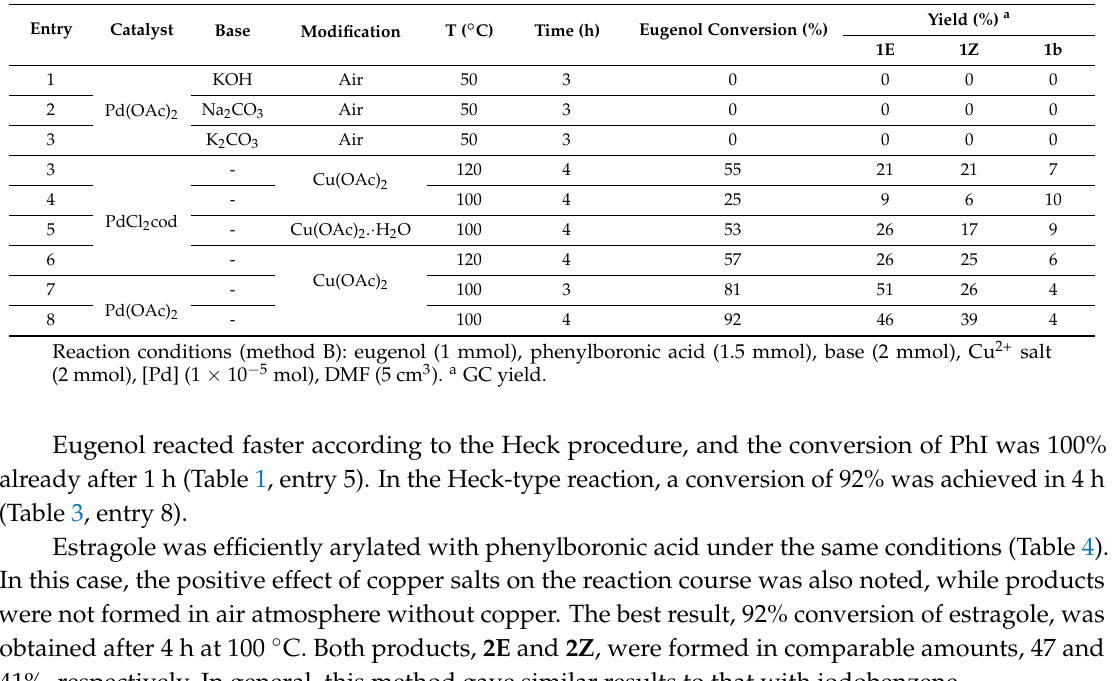
Table 3. Results of the Heck-type arylation of eugenol with phenylboronic acid.